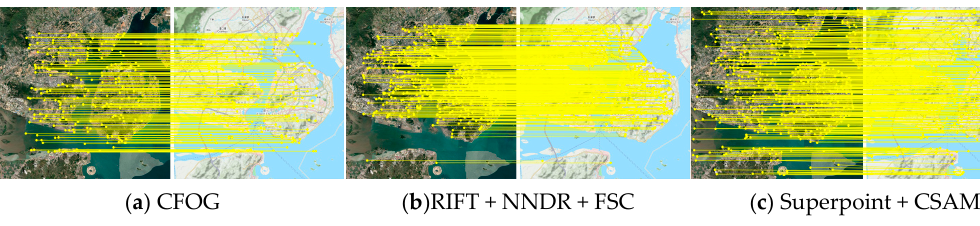
Figure 20. Optical–map matching results.